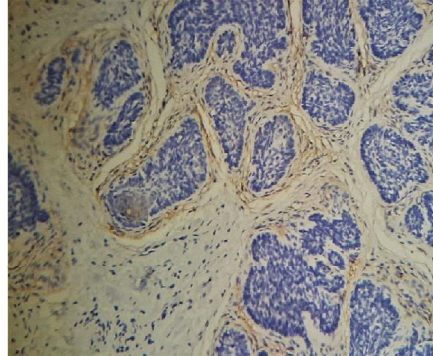
Figure 7: Peripheral stromal lining of the tumour positively stained with CD10 (H&E, high power, ∗ 40).